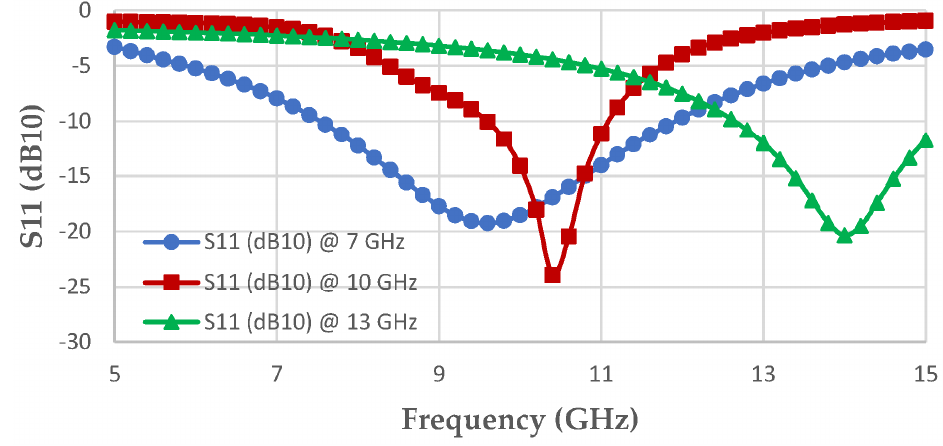
Figure 14. Simulated S11 versus frequency at 7 GHz, 10 GHz, and 13 GHz.